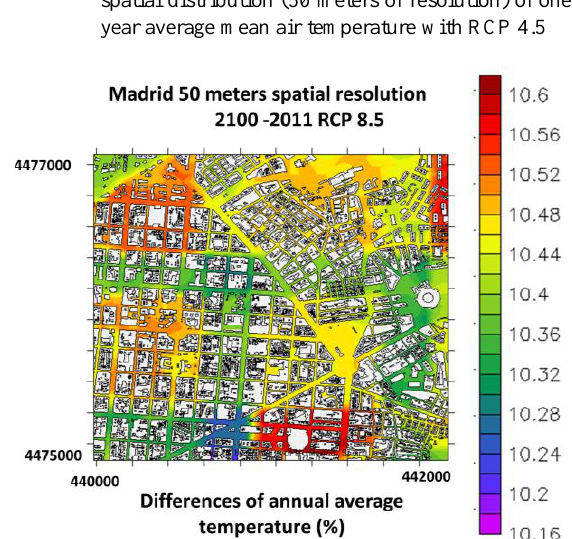
Figure 5. Madrid differences (%) between 2100 and 2011 spatial distribution (50 meters of resolution) of one-